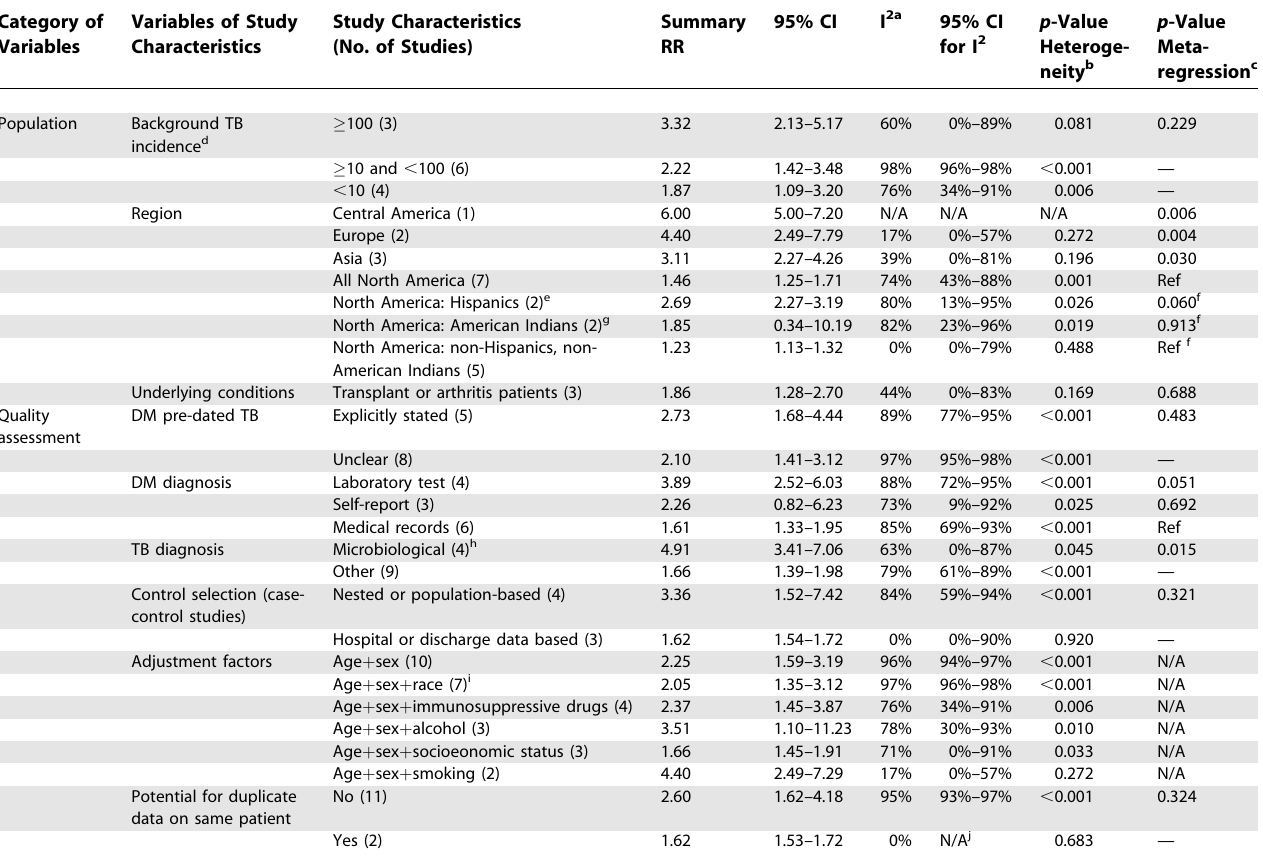
Table 2. Results of Sensitivity Analyses to Identify Sources of Heterogeneity in the Magnitudes of the Association between